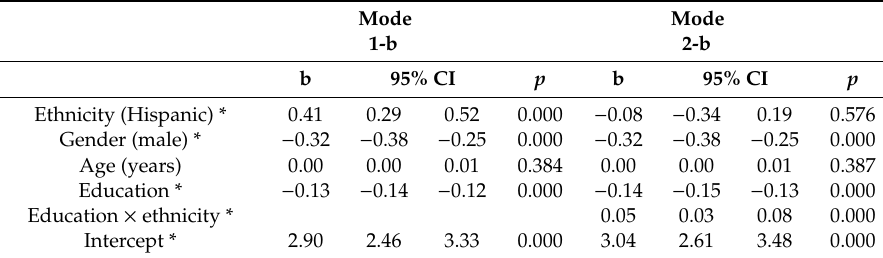
Table 4. Pooled sample linear regressions for mean depressive symptoms over 24 years as the outcome.